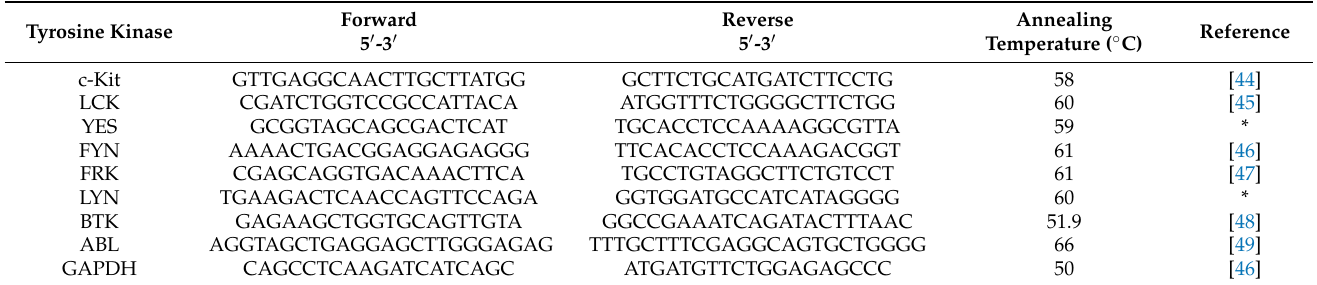
Table 2. Oligonucleotides that were used for the analysis of tyrosine kinases gene expression by